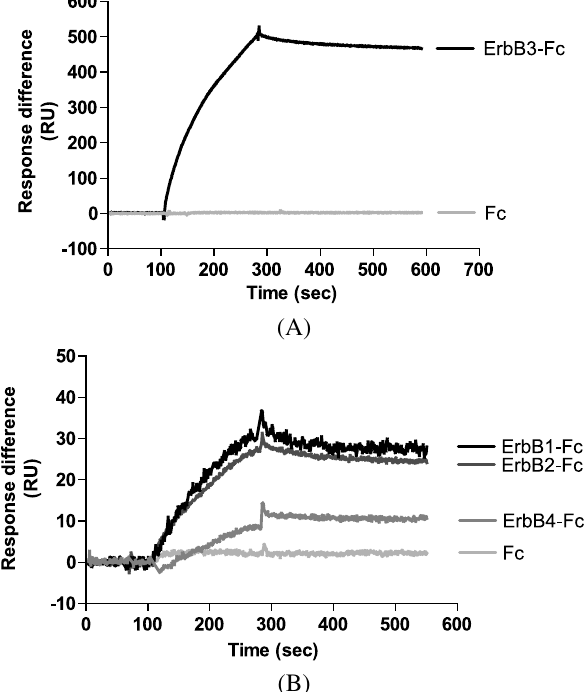
Fig. 2. Binding of ErbB receptors to Inherbin3. The Inherbin3 peptide was immobilized on the sensor chip, and recombinant chimeric proteins comprising the extracellular parts of the four ErbB receptors fused to the Fc part of human IgG were injected in concentration of 0.37 µM (ErbB2, ErbB3, ErbB4 and Fc alone) and 0.18 µM (ErbB1). Binding is expressed as the response difference between the binding to the sensor chip with the immobilized peptide and a blank sensor chip. (A) Binding of ErbB3–Fc and Fc to Inherbin3. (B) Binding of ErbB1–Fc, ErbB2–Fc and ErbB4–Fc, and Fc to Inherbin3.